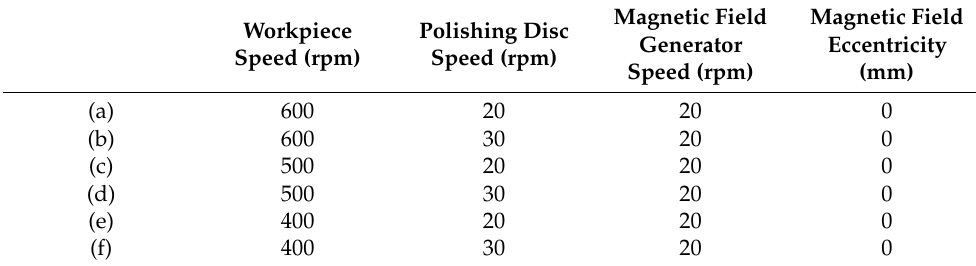
Table 7. Experimental parameters.